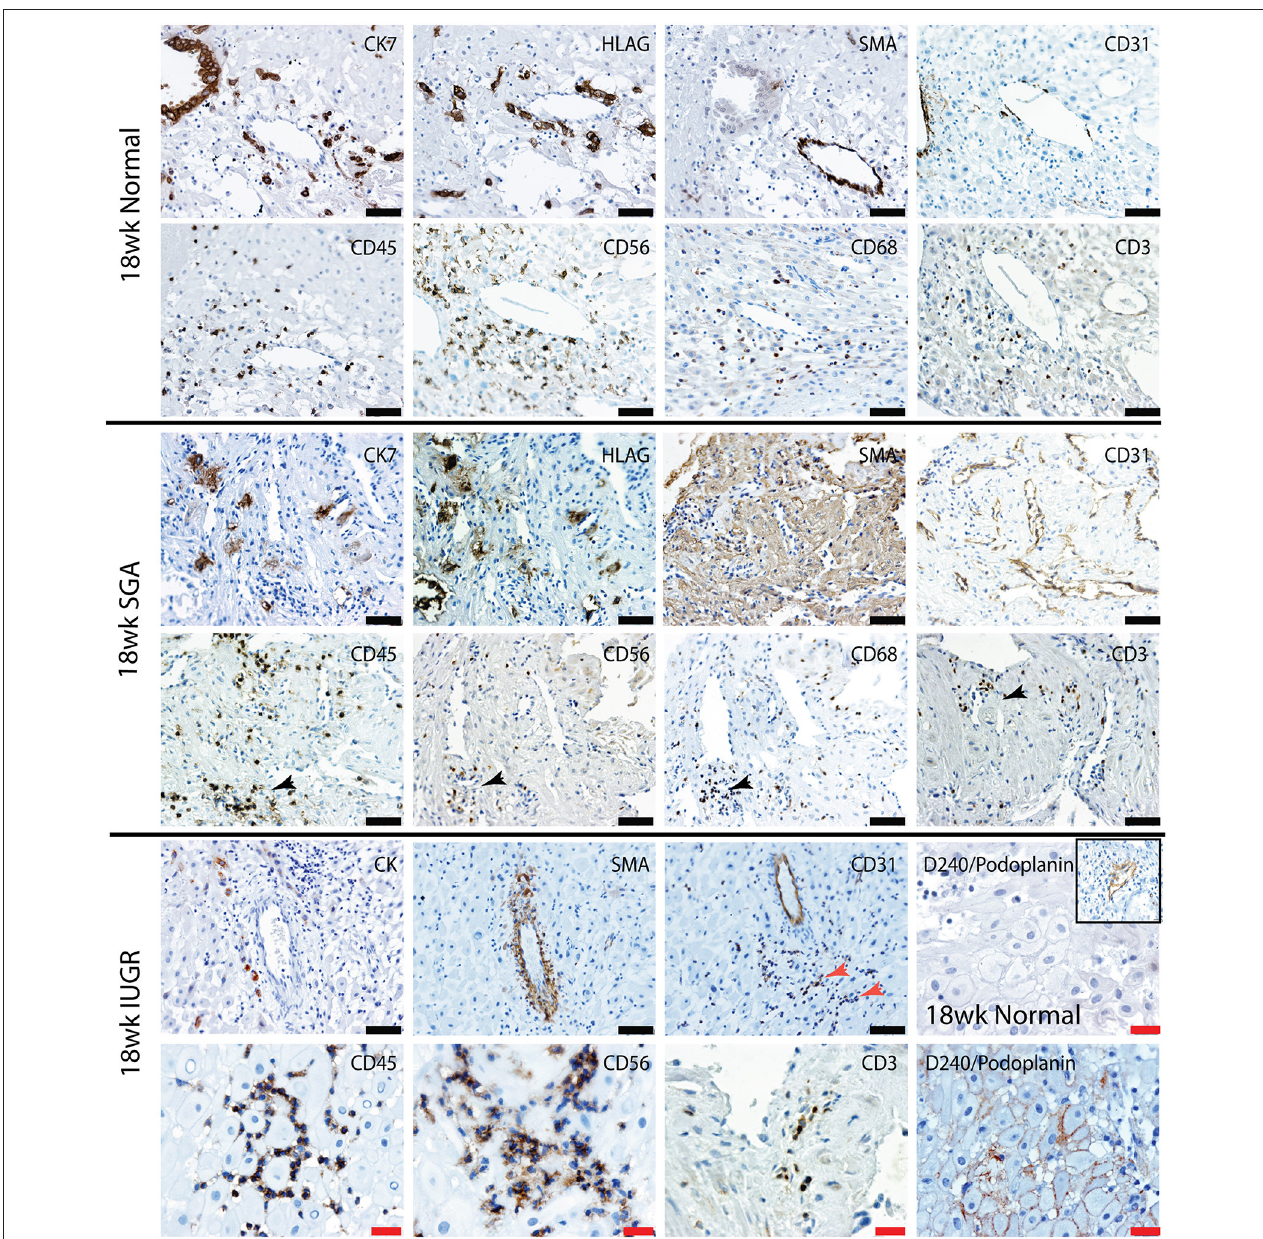
FIGURE 5 | Lymphatic vessel density is increased, and leukocytes are abnormally distributed in the high uterine artery PI SGA decidua. Representative serial sections from normal 18 week trimester decidua (top panel), an 18 week high uterine artery PI SGA case (middle panel) and a 18 week high uterine artery case of IUGR (lower panel) stained with antibodies against CK7 (trophoblast) HLAG (EVT), SMA (VSMC), CD31 (endothelial), CD45 (leukocytes) CD56 (uNK) CD68 (macrophage and CD3 (T cells). Lymphatic vessels were identified by staining with D240/podoplanin (lower right 2 images control and IUGR). In the SGA high numbers of small CD31 vessels full of leukocytes were seen (black arrows) In the IUGR decidua this was more pronounced (red arrow), abnormal D240 podoplanin lymphatic endothelial expression was found surrounding the DSC (lower right panel) creating micro-lymphatic vessels that were packed with uNK (CD56) and T cells (CD3). In controls the DSC were negative and only the larger lymphatic vessels stained positive (inset). Scale bars: black = 50 µ M, 100x magnification, red = 20 µ M, 200x